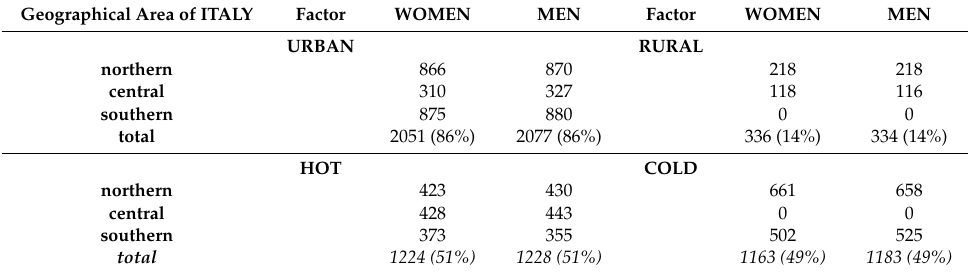
Table A2. New number of answers as distributed with respect to the two groups of participants (women and men) and the two conditions for each factor. Distributions are detailed with respect to the geographical position (North, Center or South of Italy) of the involved regions. (Data source: